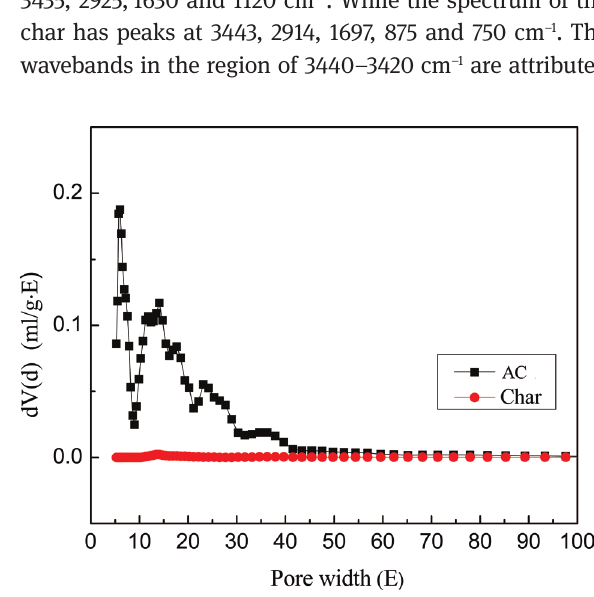
Figure 2: Pore size distribution (c) of the AC and char.